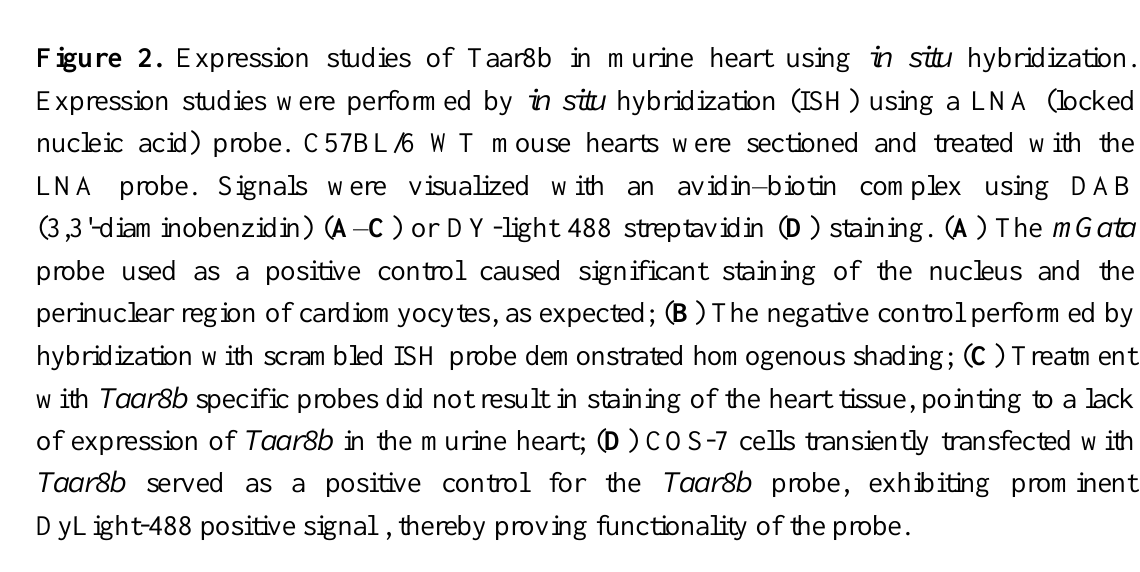
Figure 2. Expression studies of Taar8b in murine heart using in situ hybridization. Expression studies were performed by in situ hybridization (ISH) using a LNA (locked nucleic acid) probe. C57BL/6 WT mouse hearts were sectioned and treated with the LNA probe. Signals were visualized with an avidin–biotin complex using DAB (3,3'-diaminobenzidin) ( A – C ) or DY-light 488 streptavidin ( D ) staining. ( A ) The